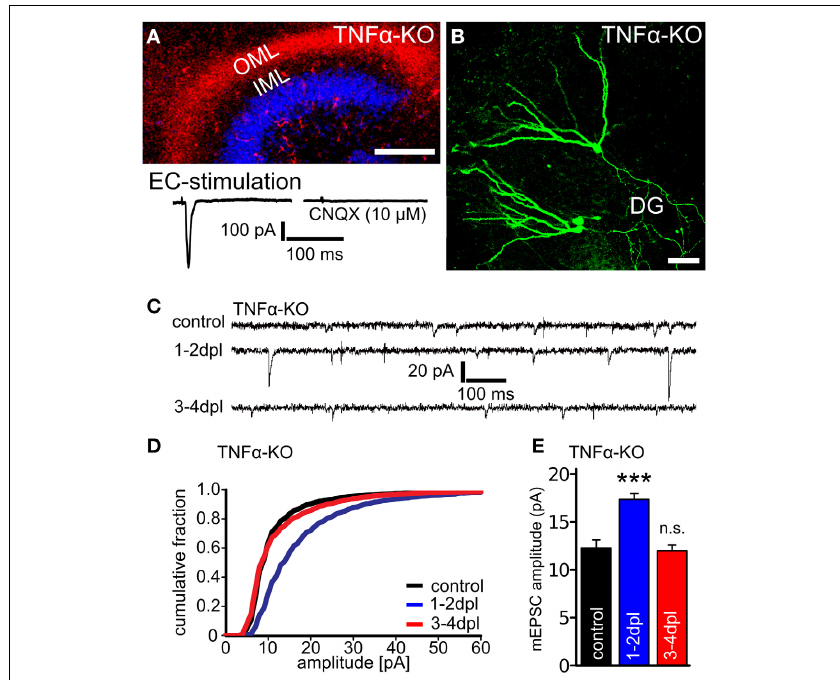
FIGURE 1 | Figure legend same as in the original article: Denervation-induced homeostatic synaptic strengthening is not observed in granule cells of TNF α -deficient slice cultures at 3–4 dpl. (A) Mini-Ruby tracing of entorhino-hippocampal axons (red; ToPRO nuclear staining, blue) and electrical stimulations of the entorhinal cortex (EC) while recording evoked EPSCs from dentate granule cells revealed an intact and functional entorhino-hippocampal projection in slice cultures prepared from TNF α -deficient mice (TNF α -KO; three independent experiments each, up to 50 traces averaged per neuron). Evoked EPSCs (amplitude: 369 ± 102pA) could be blocked by the AMPA-receptor antagonist CNQX (10 μ M; amplitude: 9.6 ± 2.1pA). Scale bar: 200 μ m. (B) Patched granule cells were filled with biocytin and post hoc identified using Alexa568- or Alexa488-streptavidin. Scale bar: 50 μ m. (C–E) Whole-cell patch-clamp recordings from granule cells of TNF α -deficient slice cultures revealed an increase in the mEPSC amplitudes at 1–2 dpl but not at 3–4 dpl ( n = 12–16 neurons per group, from six to eight cultures each). Data represent mean ± s.e.m.; ∗∗∗ p < 0 . 001; n.s., not